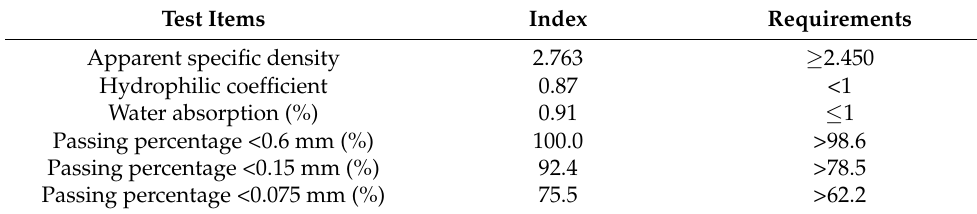
Table 4. Performance parameters of mineral powder.